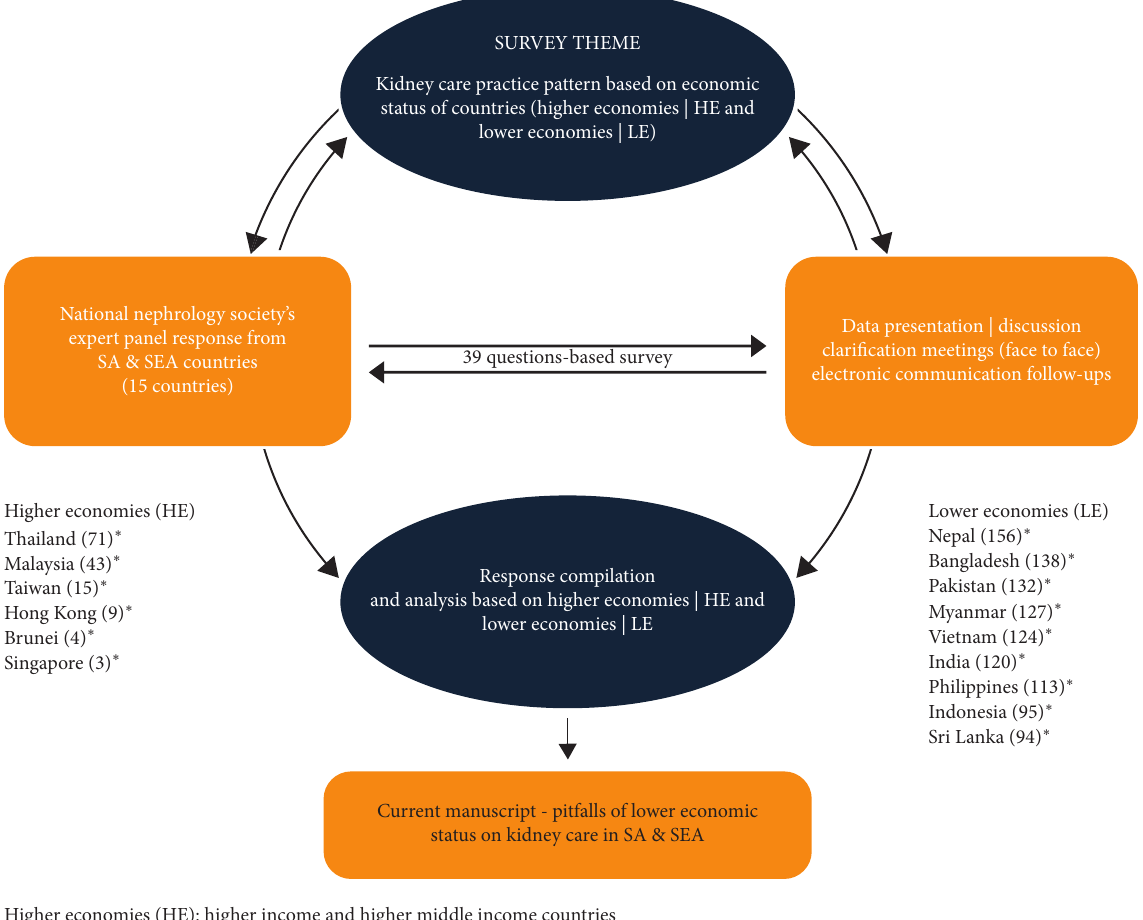
Figure 1: Schematic description of data